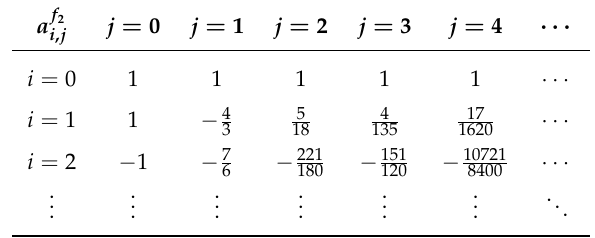
Table 2. The coefficients a f 2 of Thiele–Newton’s expansion of f 2 ( x , y ) given by Equation (30). i , j